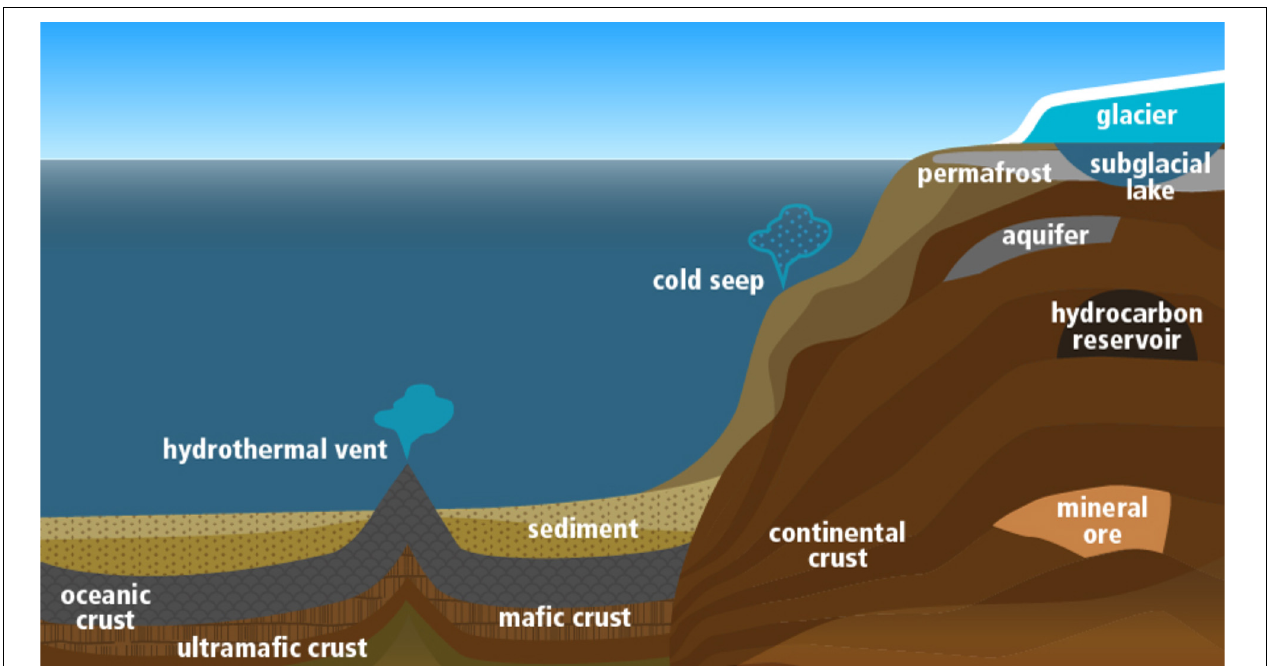
FIGURE 2 | Cross-section schematic of low energy subsurface environments on